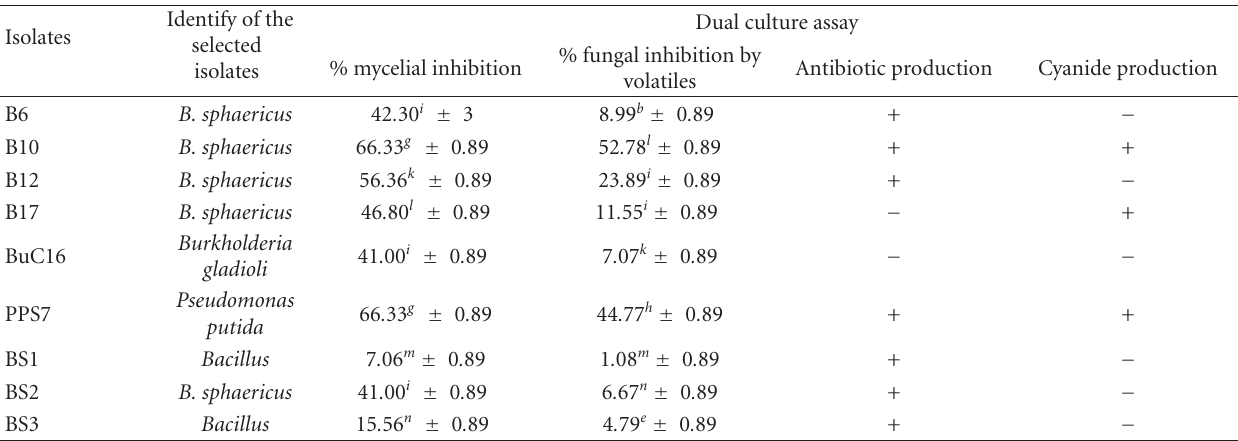
Table 2: E ff ect of Bacillus isolates obtained from the compost materials on in vitro growth of Fusarium oxysporum f.sp. radicis-lycopersici and determination of the ability of the most e ff ective bacterial isolates in dual culture on producing cyanide, volatiles and antibiotics. Identify of the Isolates selected